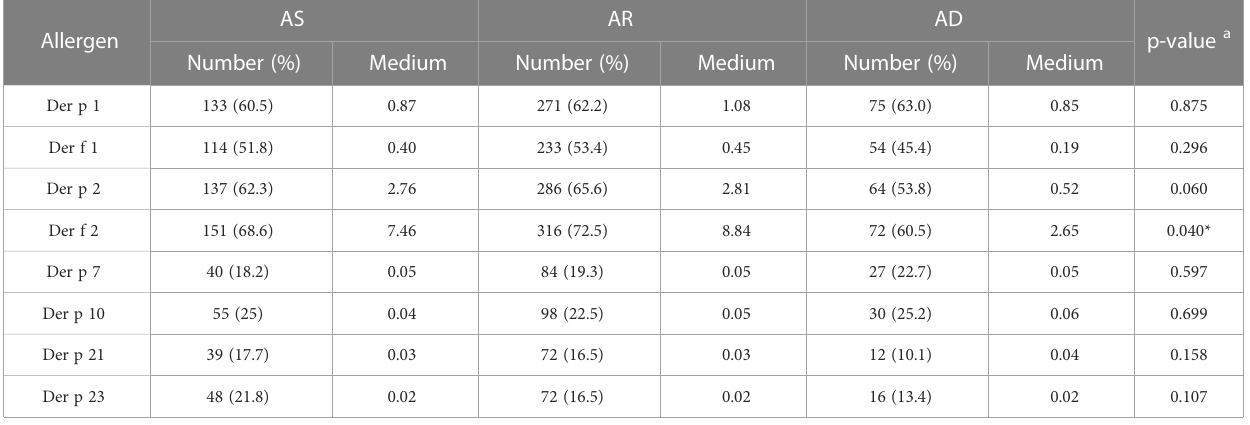
TABLE 2 House dust mite component allergen sIgE-positive numbers and constituent ratio of three symptom groups.